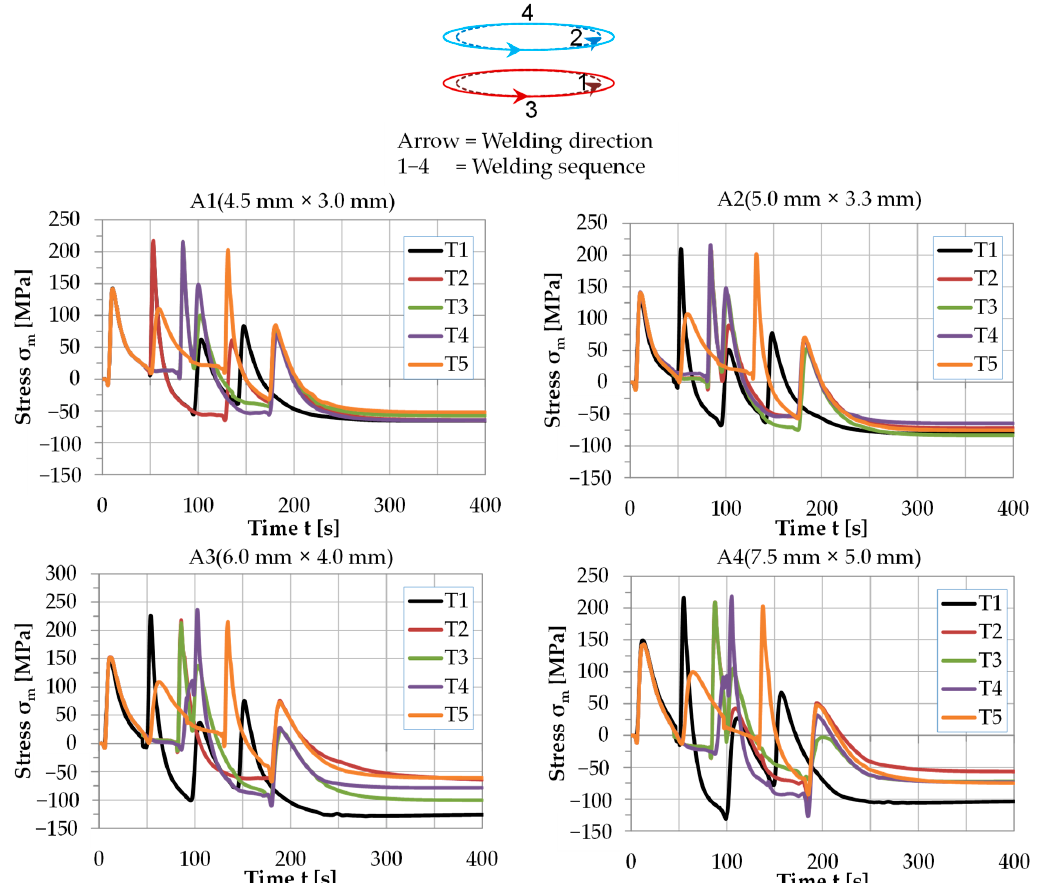
Figure 26. Comparison of the stress history of the tool-element for different welding trajectories in a 2 × 2 pattern with beads of dimensions (A1–A4).